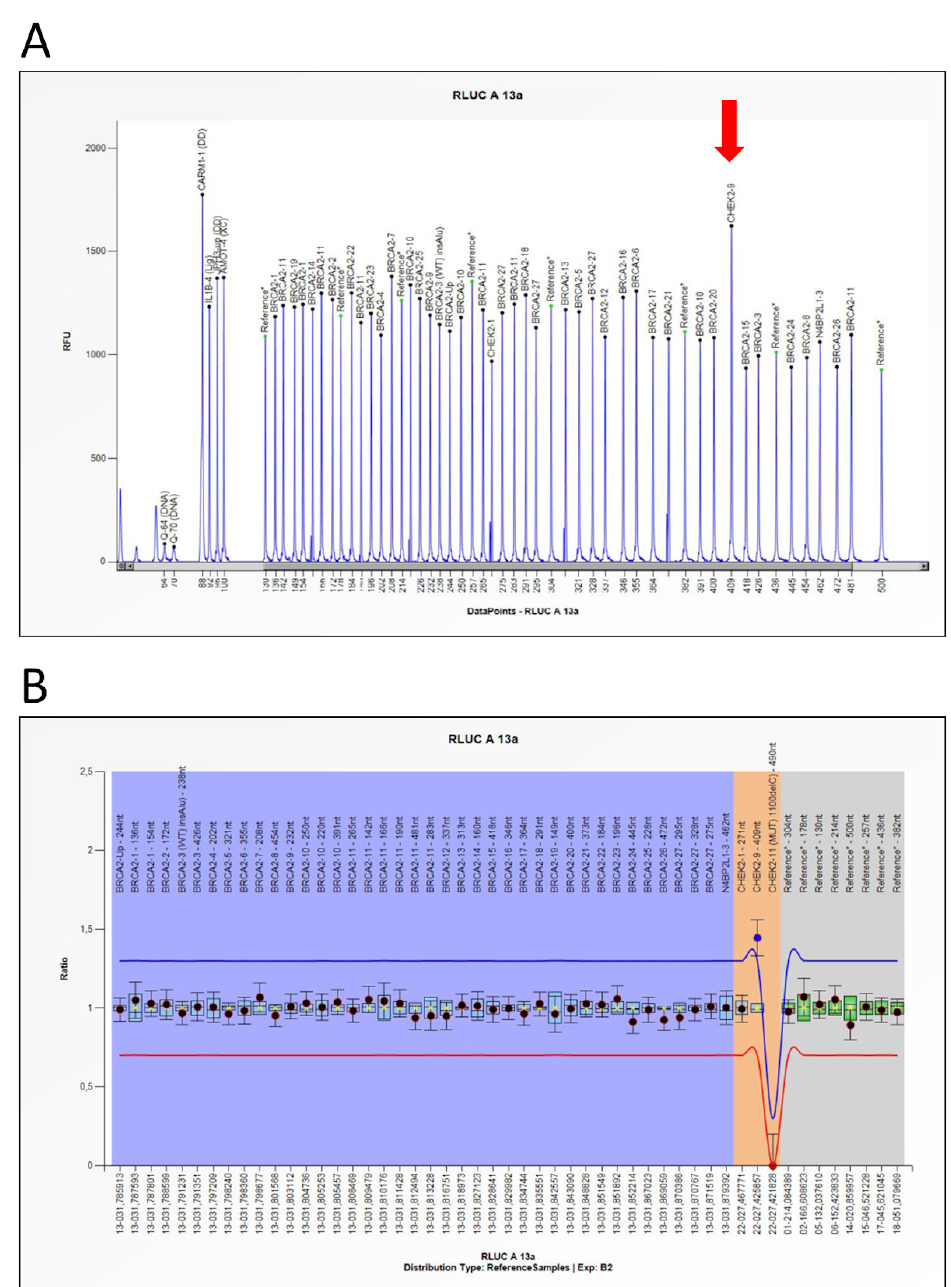
Figure 2. BRCA2/CHEK2 MLPA analysis. ( A ) BRCA2/CHEK2 P045-D1 probemix MLPA electropherogram profiles. Red arrow shows the duplication exon 9 of the CHEK2 gene. ( B ) MLPA Probemix P045-D1 BRCA2/CHEK2 contains 51 MLPA probes with amplification products between 130 and 500 nucleotides (nt) and three probes for the CHEK2 gene. The blue rhombus represents the 95% confidence interval over the reference samples for each probe. The collected data were analyzed using Coffalyser.NET Software (MRC